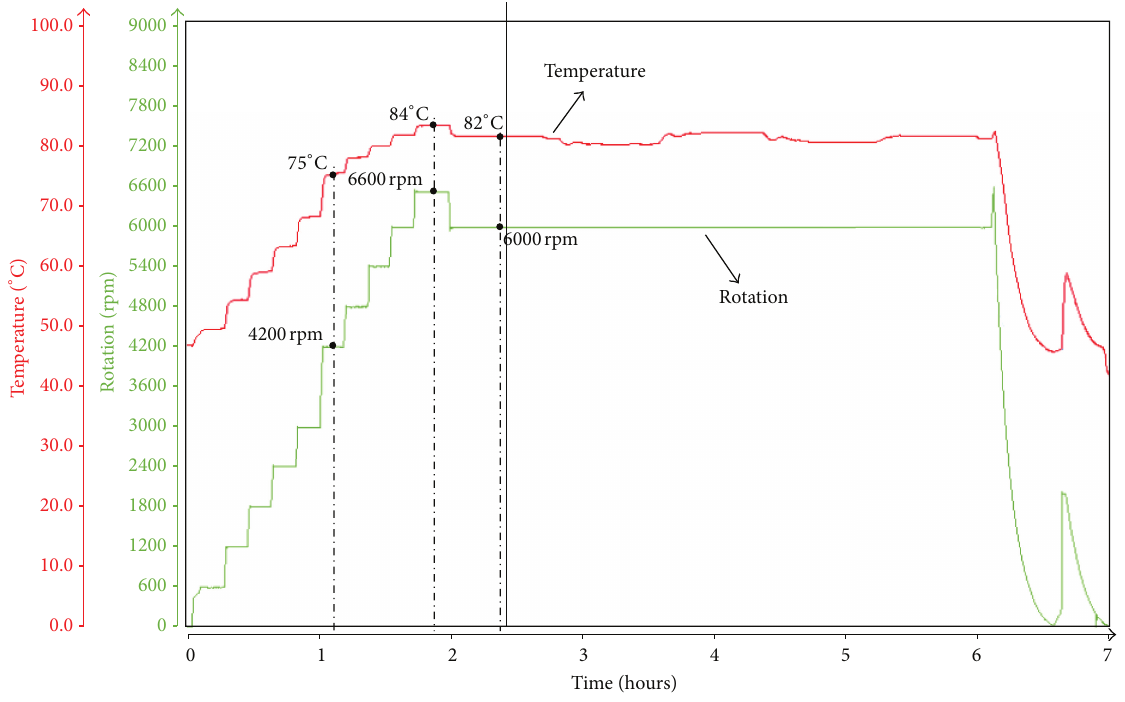
Figure 8: Temperature of the oil measured inside the